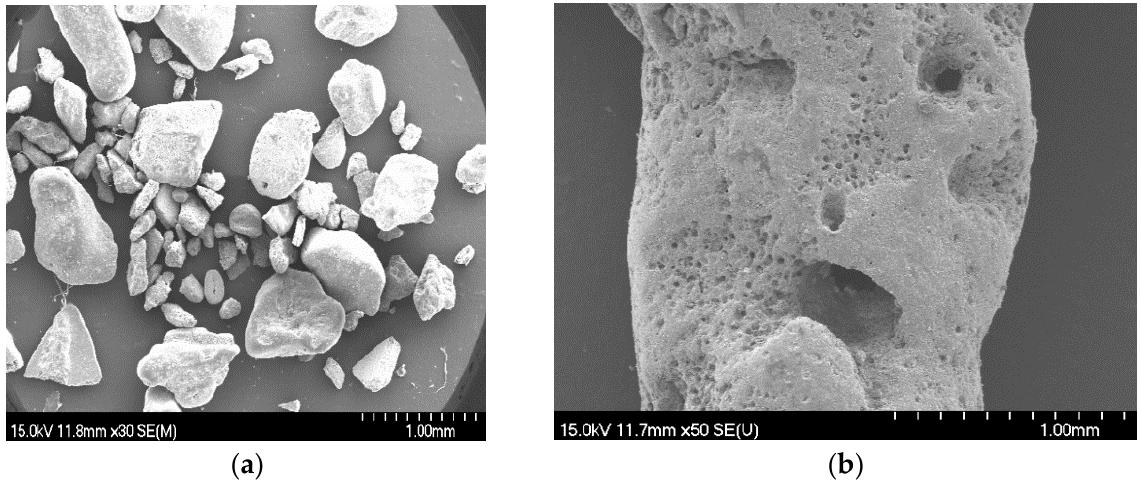
Figure 3. SEM images for the tested calcareous sand: ( a ) amplification factor of 30; ( b ) amplification factor of 50.